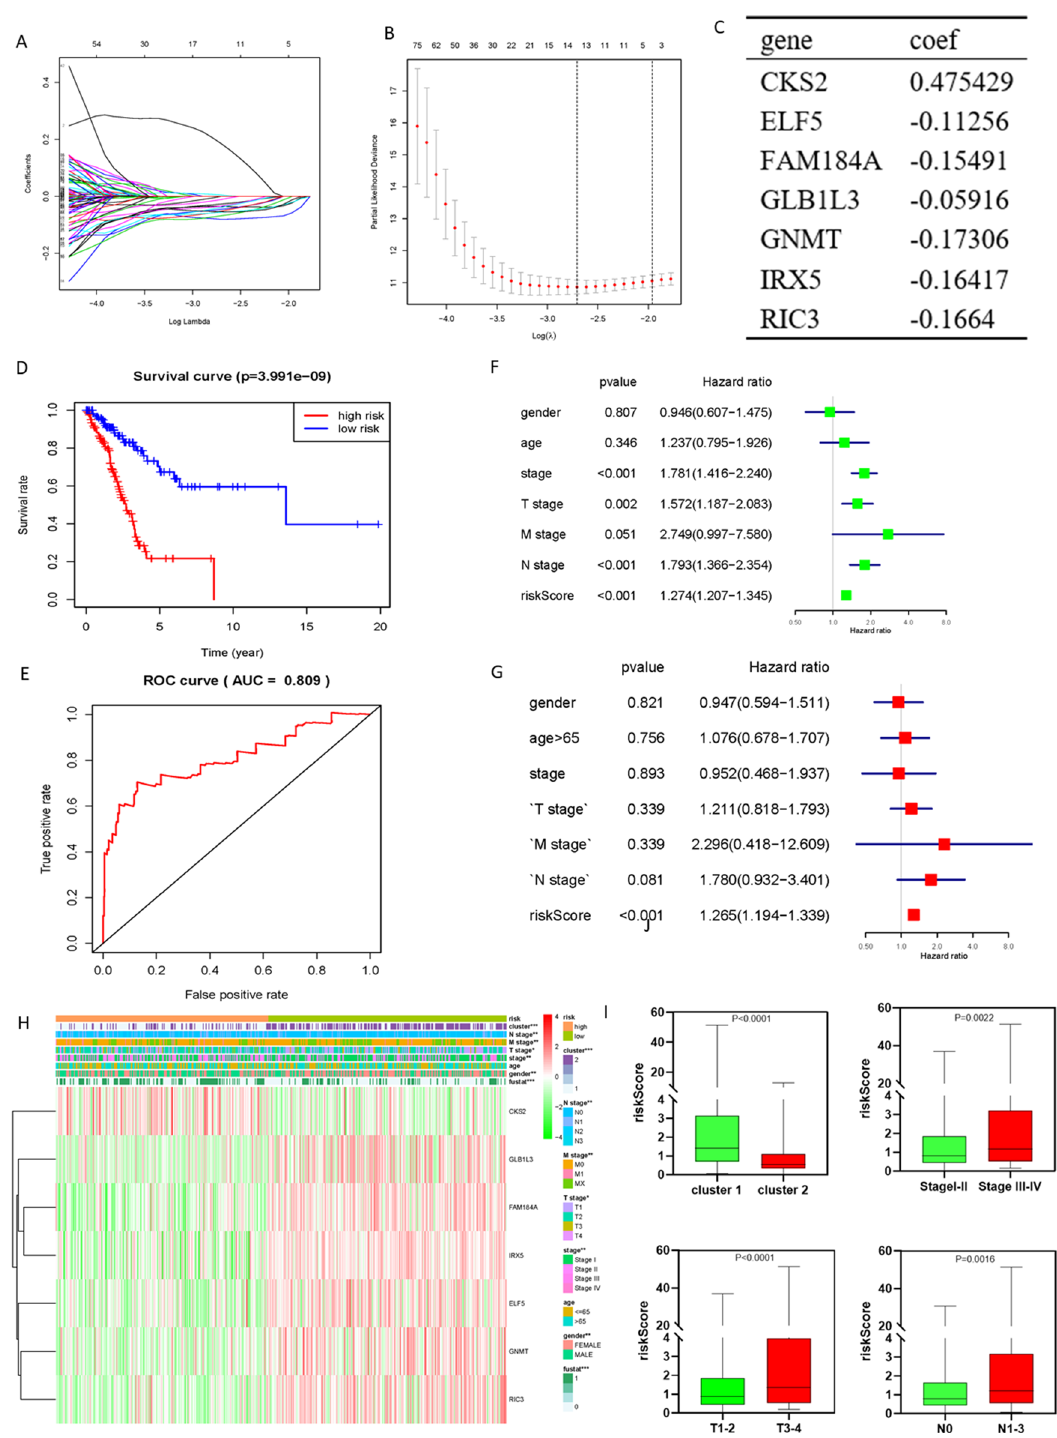
Figure 5. Construction of prognostic models based on hypoxic-related DEGs. ( A , B ) LASSO Cox regression was conducted to construct the most powerful prognostic markers. ( C ) Identify 7 powerful prognostic markers and the coefficients by multivariate Cox regression via LASSO in train set (Wilcox Test). ( D ) Kaplan–Meier overall survival (OS) curves for patients in high- and low-risk group in train set (P < 0.001). ( F ) ROC curve and AUC value for risk score in train set. ( F , G ) Univariate and Multivariate Cox regression analysis of the associated between clinicopathological features (including risk score) in train set. ( H ) The heatmap shows the expression of the 7 powerful prognostic markers and the distribution of clinicopathological characteristics in high-risk group and low-risk group of all TCGA-LUAD samples (Chi-square Test). ( I ) The relationship between Rick score and cluster status, TNM stage, T stage and N stage (Wilcox Test). *P < 0.05, **P < 0.01, and ***P <